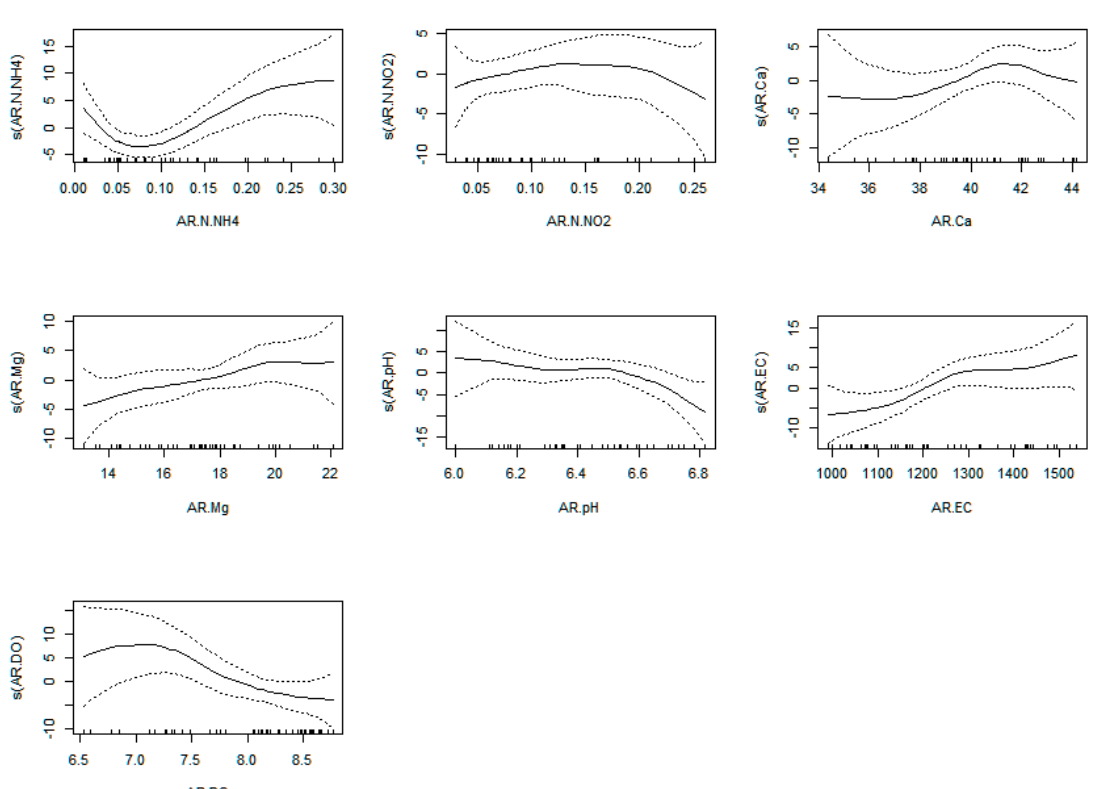
Figure A19. The GAM predictors influence over N-NO 3 for AR experimental variant.